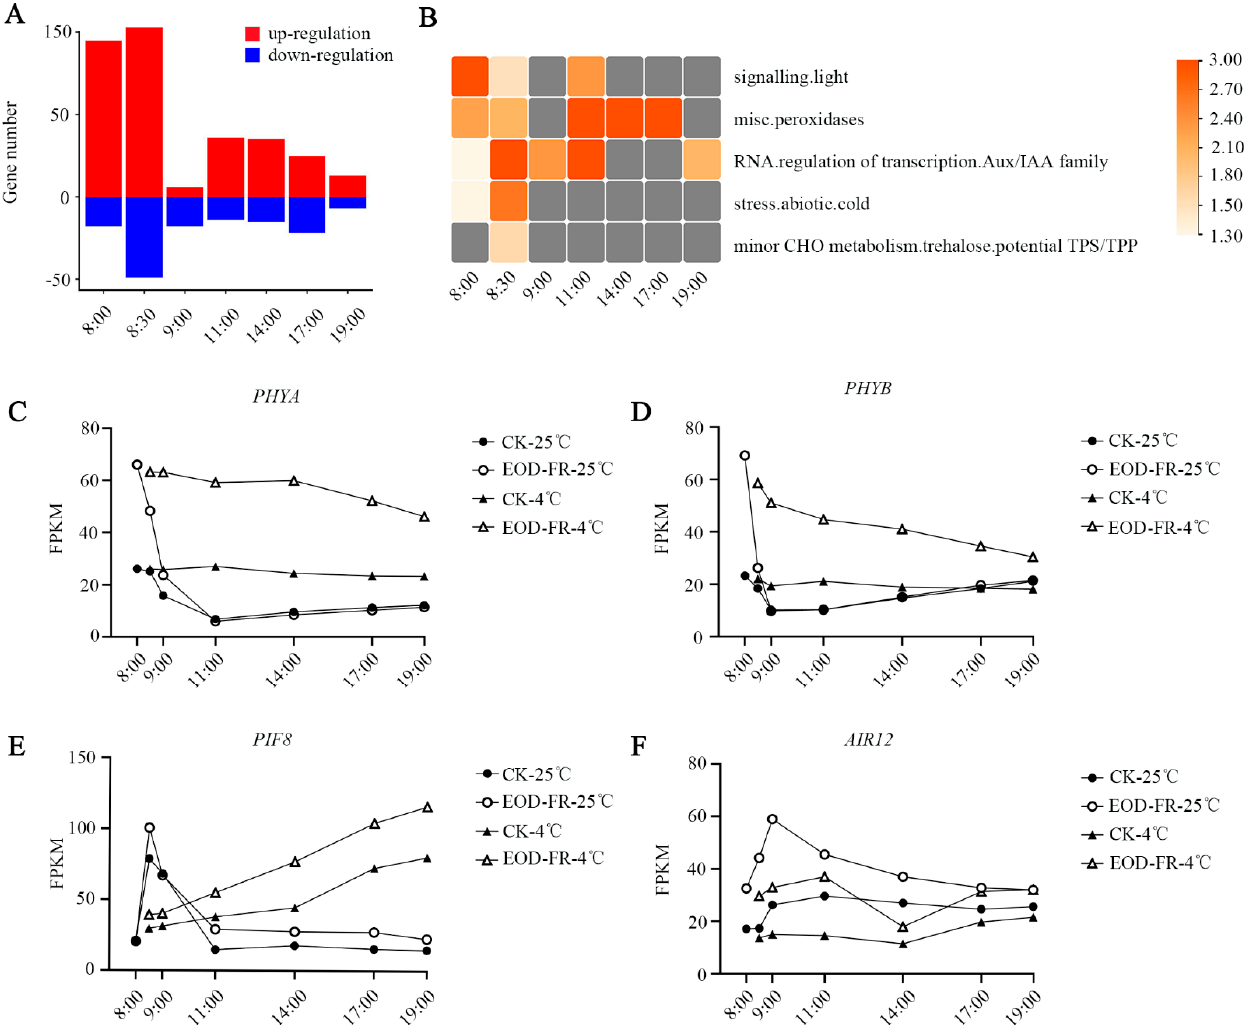
Figure 5. Effects of EOD-FR in Setaria viridis . ( A ) The number of differentially expressed genes after EOD-FR treatment. ( B ) MAPMAN enrichment analysis of DEGs after EOD-FR treatment. Only significant categories (FDR < 0.05) were displayed. ( C – F ), The expression of PHYA (C), PHYD (D), PIF8 ( E ), and AIR12 ( F ).